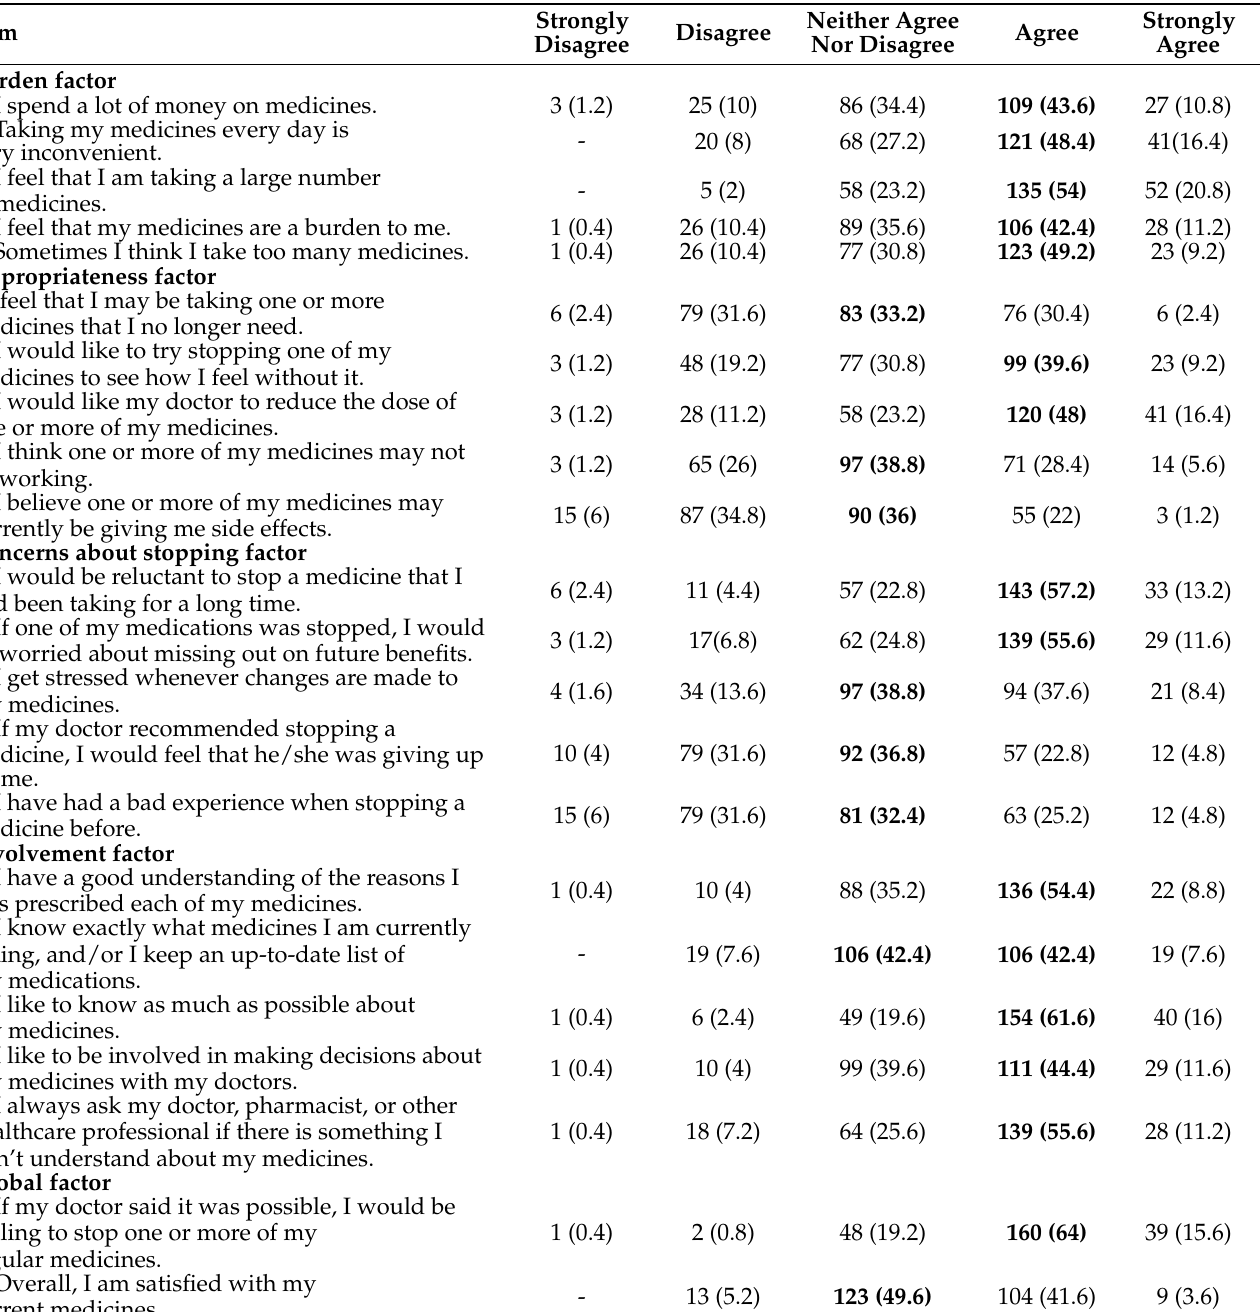
Table 3. Patients’ responses to the rPATD questionnaire about awareness of current medication use